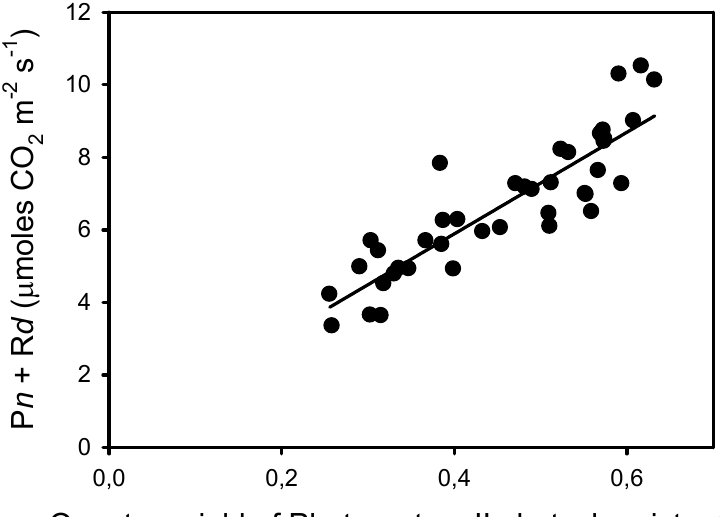
Figure 3. Correlation (R 2 = 0.780, sum of squares = 28.6, p < 0.0001) between the rates of apparent photosynthesis (P n + R d ) and the corresponding quantum yields of photochemical reactions YII measured at ten frequencies and on four leaves from different plants.